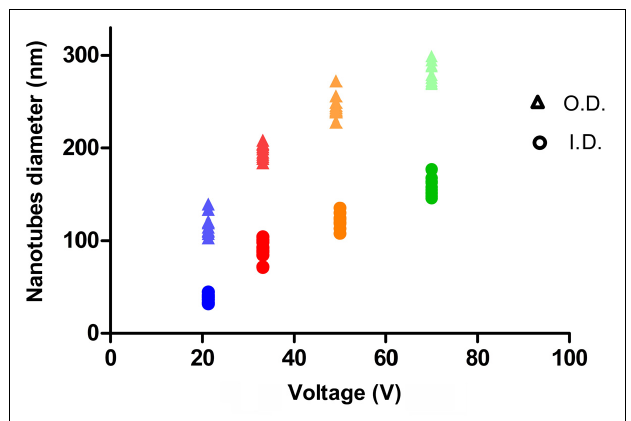
FIGURE 1 | Diameter vs. voltage relationship in NTs’